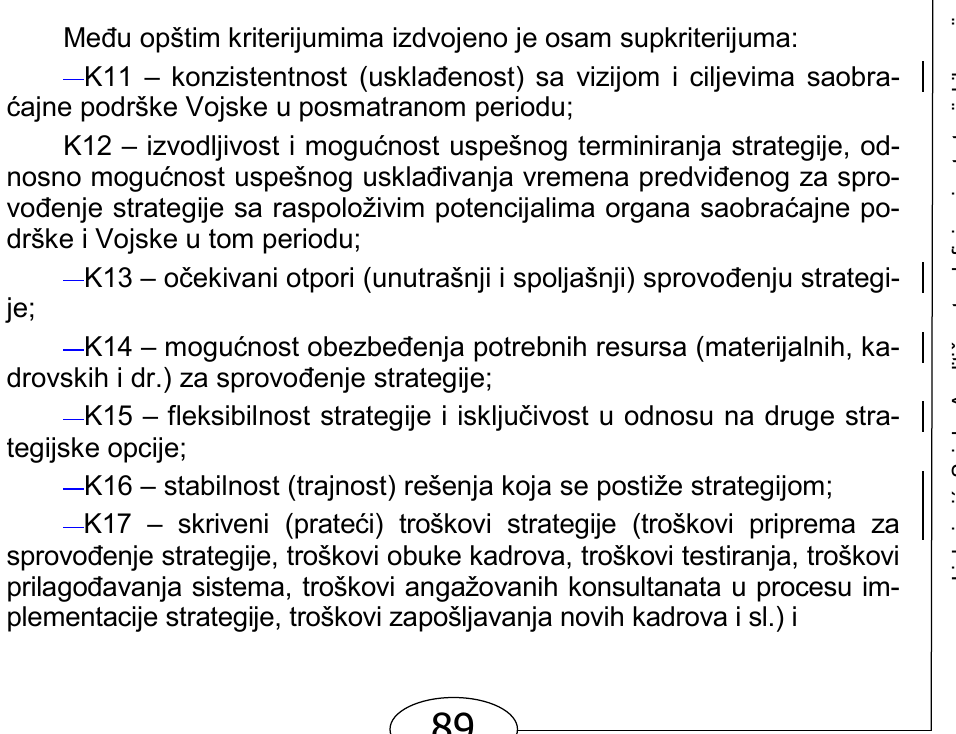
Figure 6 – Hierarchical structure of the evaluation of multimodal transport strategies